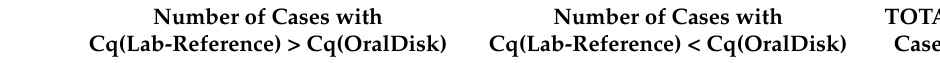
Table 3. Number of cases where the Cq(Lab-reference) was higher or lower than the Cq(OralDisk). Calculations are based on the scatter plots in Figure 5. The bacteria A. actinomycetemcomitans , Lactobacillus spp. and S. sobrinus are given only indicatively as their total cases were very